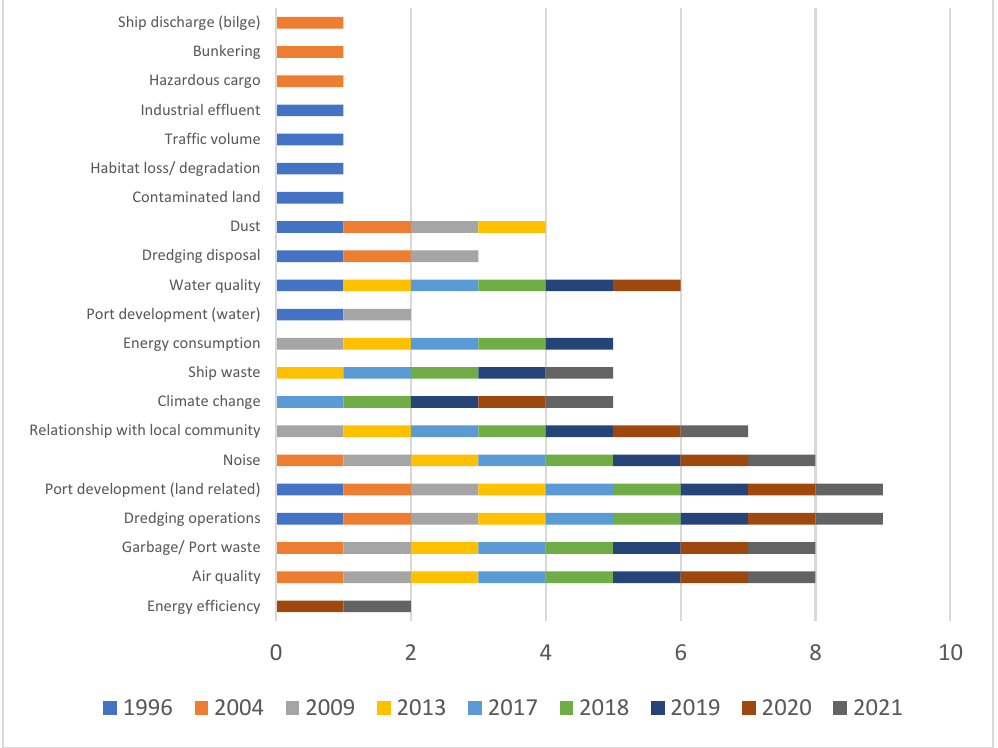
Figure 1. Environmental priorities monitored by seaports in the period form 1996–2021 Source: own elaboration on the base of: [22 – 39].